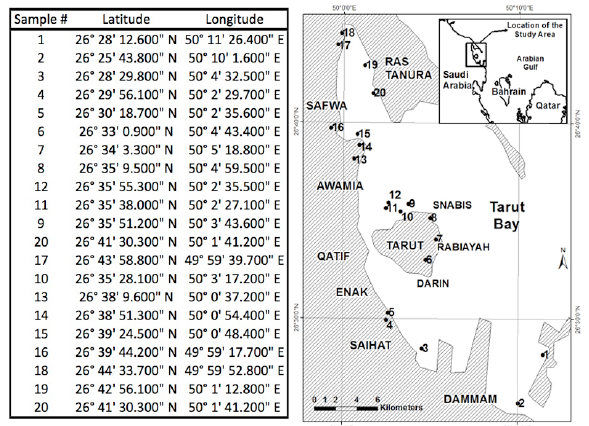
Figure 1: Map of the study area (Tarut Bay) with the names of the main coastal cities / villages along the bay and locations and coordinates of the 20 sampling locations. Coordinates are based on WGS84 reference system.